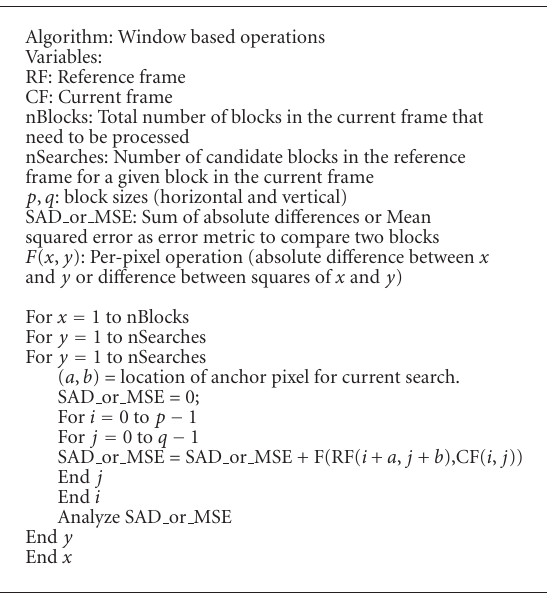
Figure 1: High-level pseudocode to illustrate the window-based operations that are targeted for